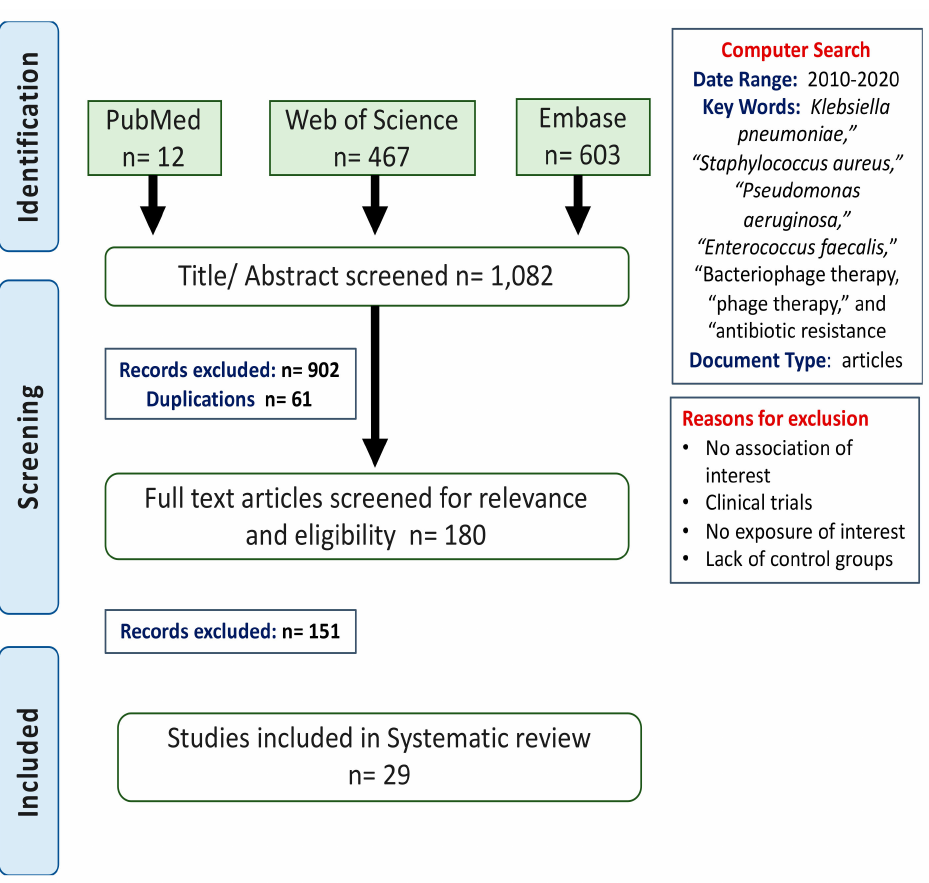
Figure 1. Flow diagram of search process. The diagram is divided into three steps; identification, screening, and articles included. Search terms and date range were identified in the computer search box. Eligible studies included in vivo, and in vitro models infected with one of the four selected pathogens and were treated with bacteriophage specific to the pathogen. All clinical trials were excluded. Abbreviations; n: number of